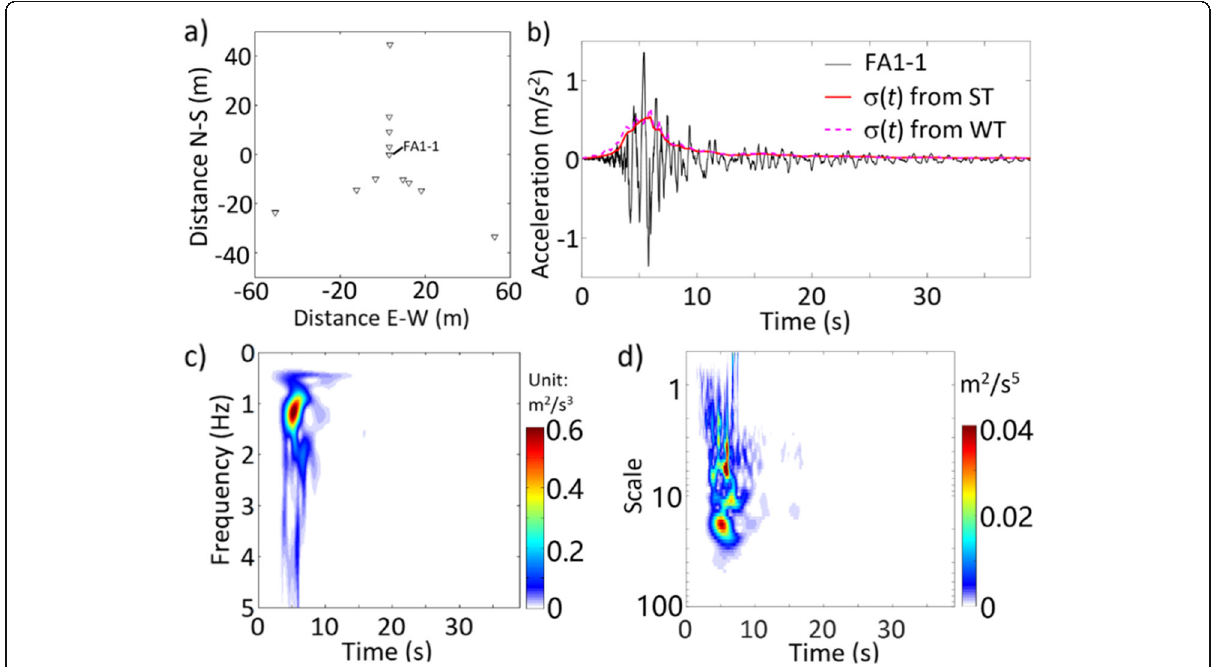
Fig. 8 a The LSST array station of selected records, b record at FA1 – 1 station, c average TFPSD by using ST based on 12 records, and d average TSPSD by using WT based 12